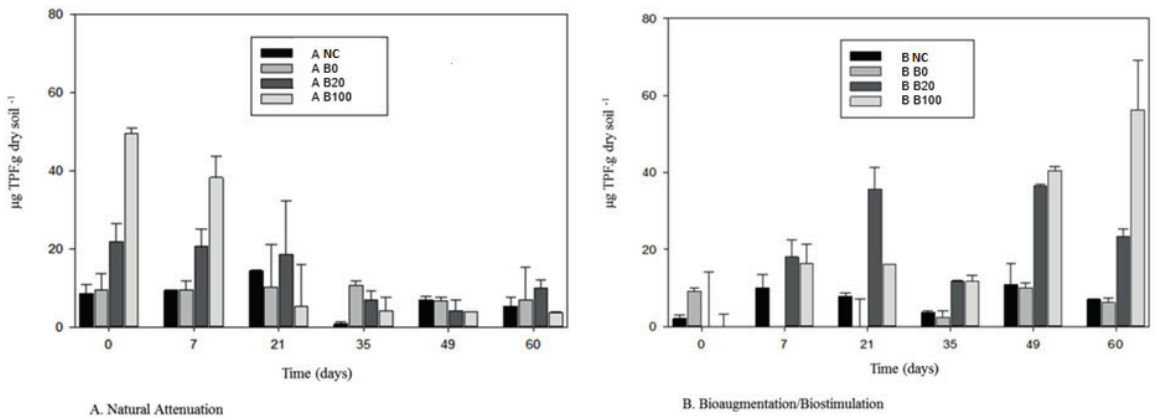
Figure 2 - Dehydrogenase activity in an ultisol contaminated with different fuel types (B0, B20 and B100) in two bioremediation strategies: natural attenuation (A) and bioaugmentation/biostimulation (B) during 60 days of incubation. A NC (A: natural attenuation, NC: control treatment without contamination). B NC (B: bioaugmentation/biostimulation, NC: control treatment without contamination). B0: pure diesel; B20: 20% biodiesel added to diesel; B100: pure biodiesel.